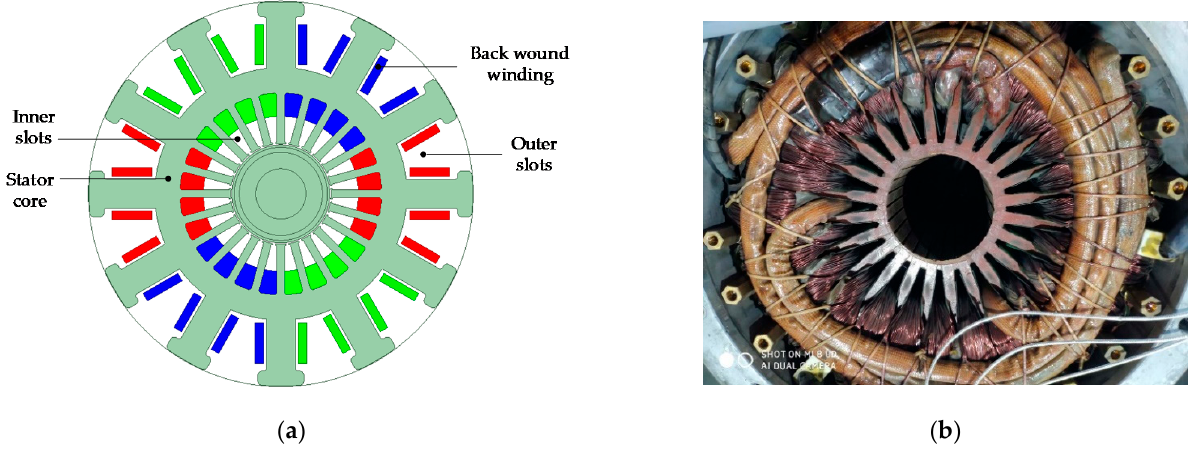
Figure 2. Back ‐ Winding structure of total high ‐ speed PM motor: ( a ) the model structure of back ‐ Figure 2. Back-Winding structure of total high-speed PM motor: ( a ) the model structure of back- winding method; ( b ) the physical photo of the stator winding. winding method; ( b ) the physical photo of the stator